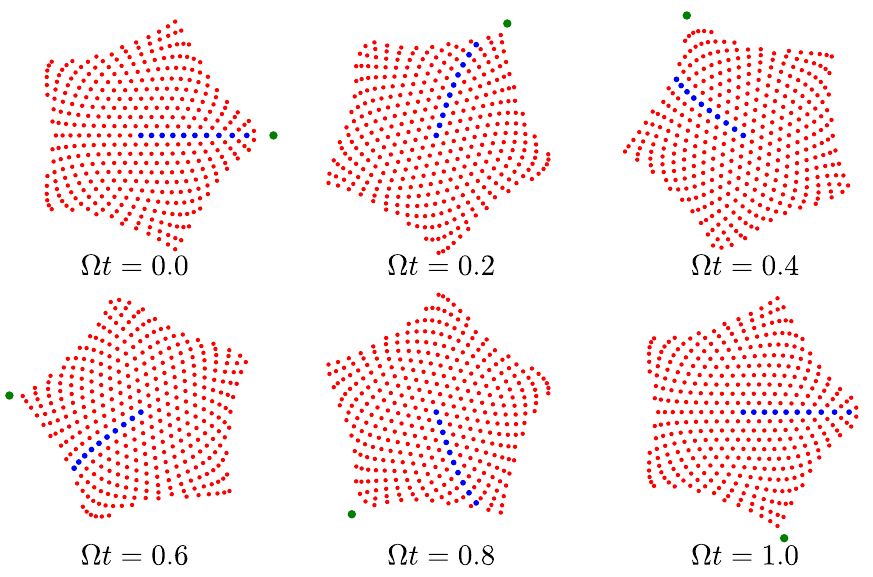
Figure 6: The n = 4 mode. A reference set of vorticies are highlighted in blue, and orbit the center with angular frequency Ω . A reference deformation peak is indicated by the green dot, and orbits the center with angular velocity n